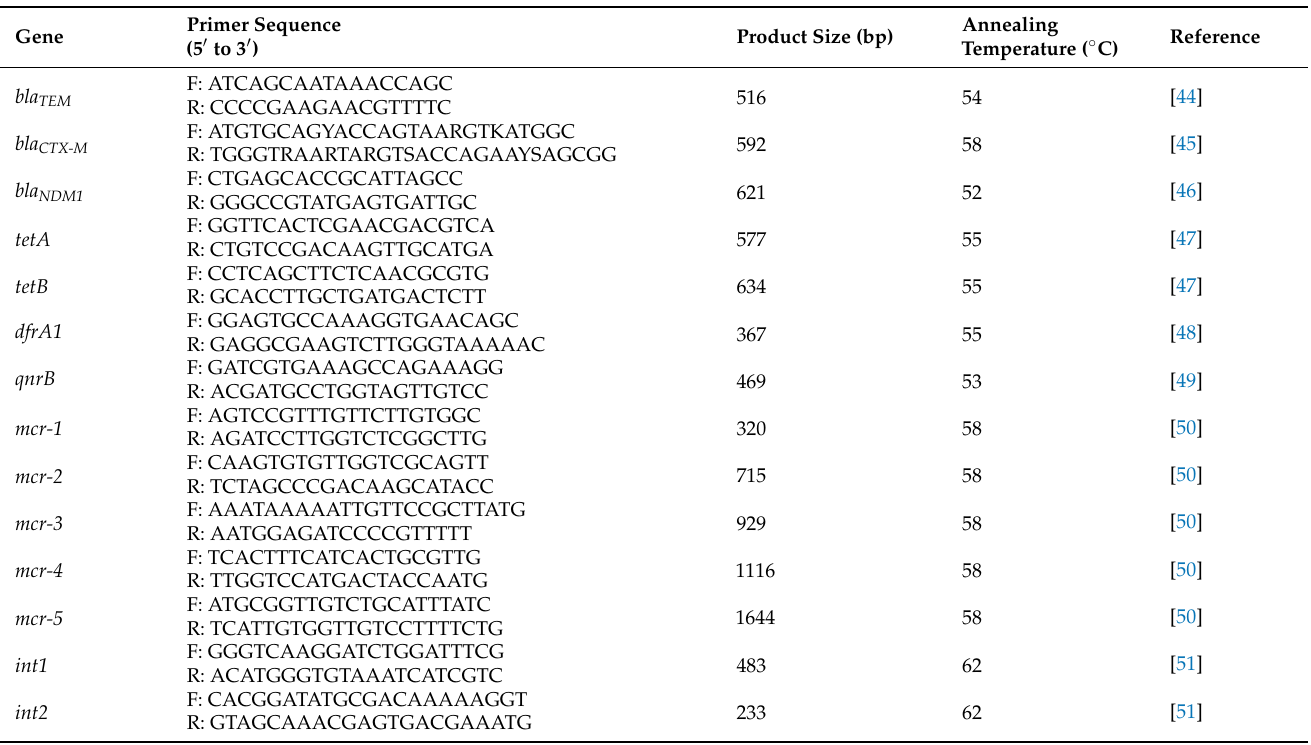
Table 4. Primers of Salmonella for antibiotic resistance genes targeted in the present